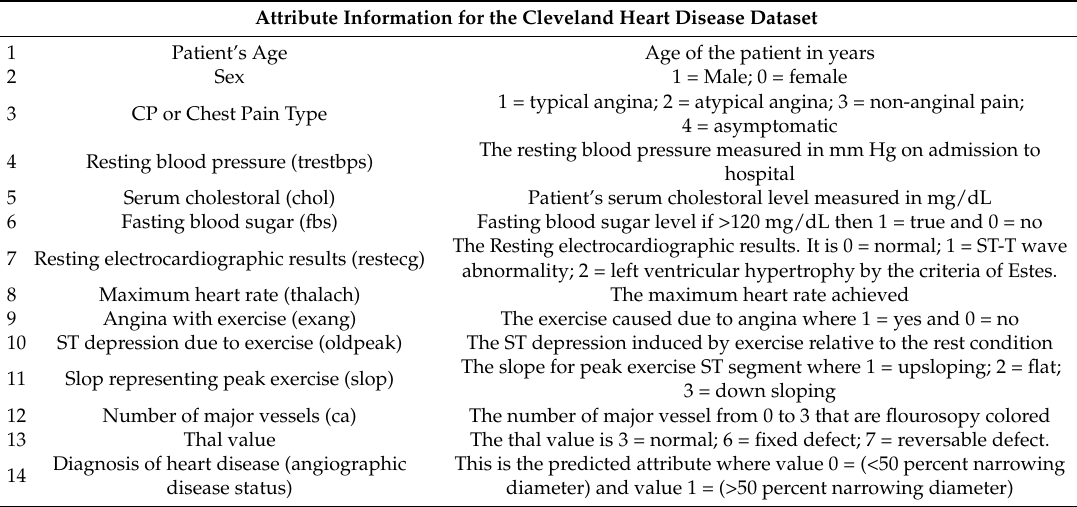
Figure 16. Heart disease dataset attributes. Table 3. Heart disease dataset description.